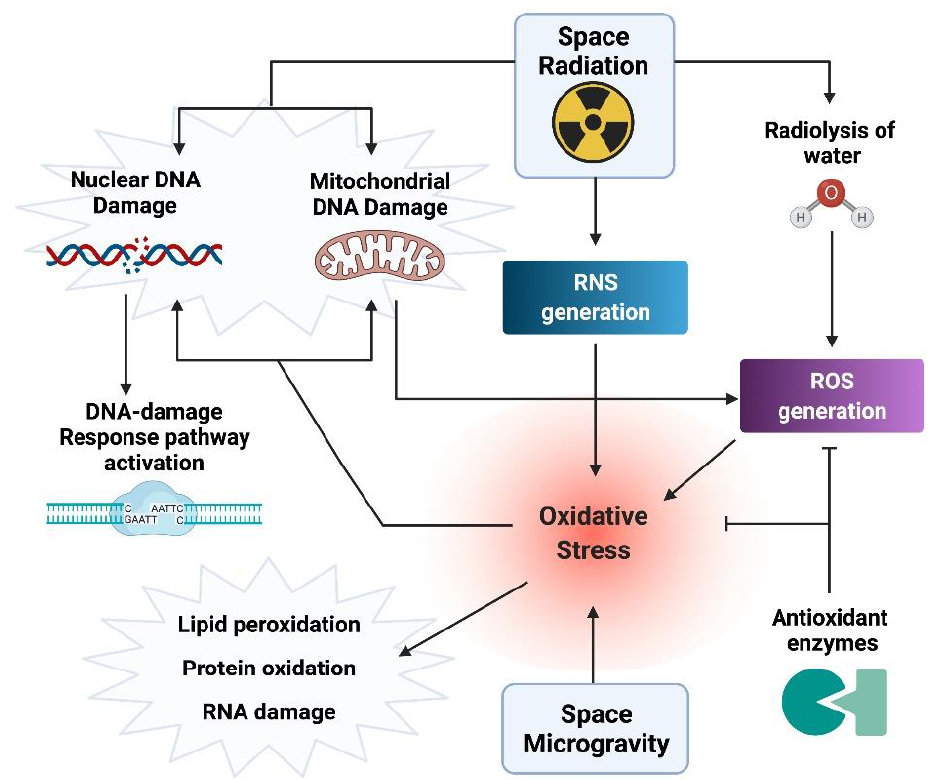
Figure 1. Scheme of the OsaD response in the space environment. The space environment is charac- terized by a mixture of ionizing radiation of different quality and by reduced gravity (microgravity). Under these conditions, reactive oxygen species (ROS) are generated by radiation-induced water radiolysis and by microgravity causing oxidative stress leading to cellular damage in the form of oxidative DNA/RNA damage, lipid peroxidation, protein oxidation, and impairment of antioxidant activity. Reactive nitrogen species (RNS) induced by radiation also participate in the increase of oxida- tive stress. Once activated, the OsaD response interfaces with the DNA-Damage Response pathway to counteract the combined effects of radiation and microgravity. “Created with BioRender.com”. Oxidative DNA damage consists mainly of oxidized bases, among which 8-Oxo-7,8- dihydro-2 (cid:48) -deoxyguanosine (8-oxodGuo) is the most frequent and is used as a cellular biomarker of oxidative stress [33]. In addition to purines, pyrimidines are also damaged by ROS, leading to oxidized pyrimidine derivatives such as thymine glycol (Tg) and 5,6 dihy- drouracil (DHU) that can block DNA and RNA polymerases [33]. The presence of ROS also creates oxidized base-derived apurinic/apyrimidinic sites and SSBs [34], whereas RNS mainly causes protein modifications in the form of tyrosine nitration and S-nitrosylation of cysteine that alter the normal activity of proteins [29]. Reactive oxygen and nitrogen species take part in intracellular signaling cascades regulating several physiological functions [35]. In this regard, several transcription factors are sensitive to changes in ROS/RNS levels and can activate specific signaling pathways [29]. The amount of direct and indirect DNA damage is strictly related to the radiation quality and dose but may also be observed in cells that were not directly irradiated giving rise to a non-targeted (bystander) effect [27,36]. Not only DNA but also ribosomal RNA undergoes oxidative damage in the presence of oxidative stress [37]. Notably, mitochondria, by generating mitochondrial ROS during cellular respiration, contribute to an increase in oxidative stress. Different studies have demonstrated that OsaD has a significant impact on human physiology as the changes in oxidative levels of irradiated cells may remain for days after exposure leading to long-term effects [38] in addition to serving as a plasma biomarker